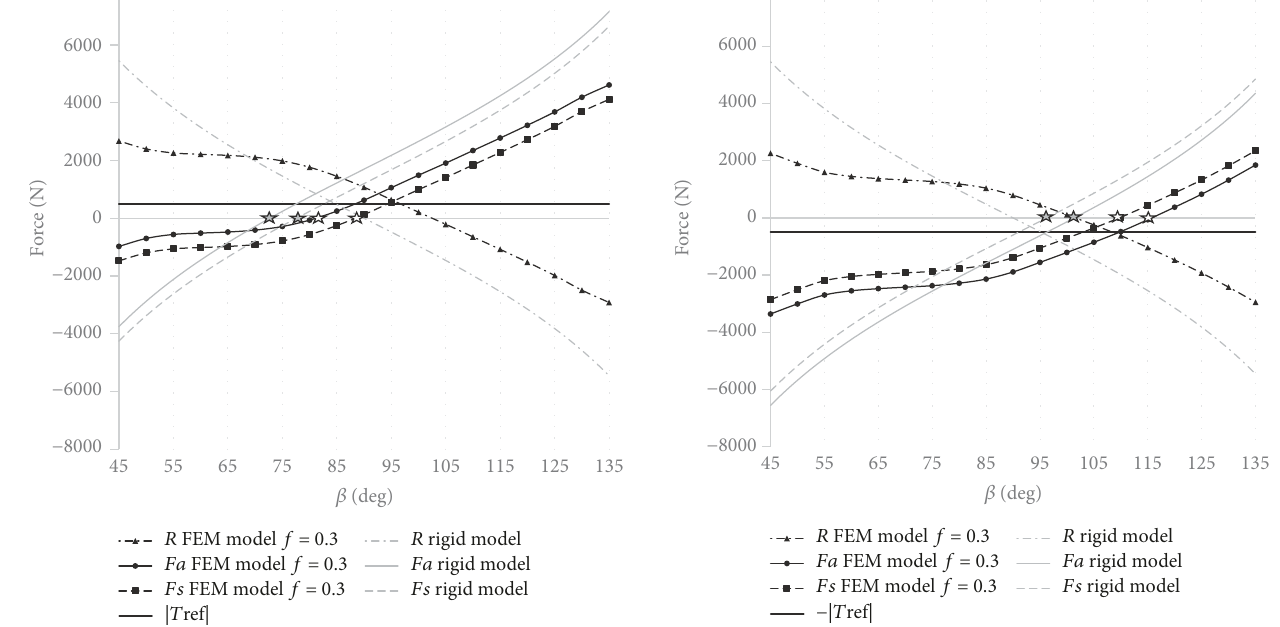
Figure 15: Graphical design method: trends of axial bearing thrusts and load transfer as a function of lead angle in nominal operating conditions in case B.